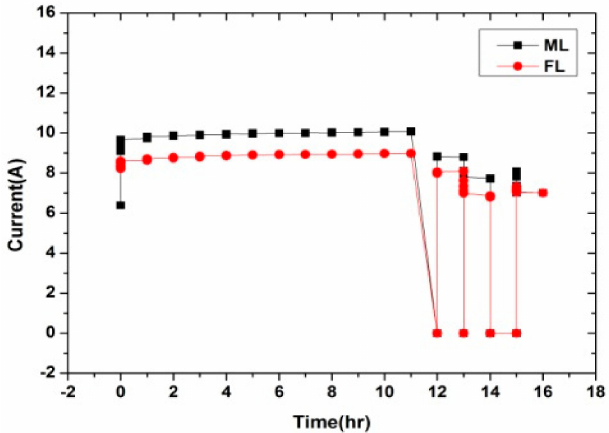
Figure 4. Accelerating test – high voltage with power interruption and restoration (4.5 V).